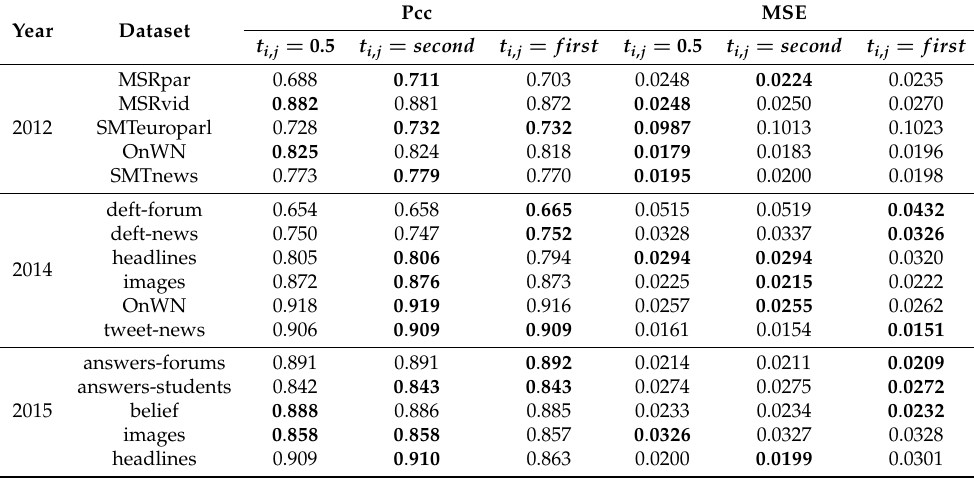
Table 6. Influence of parameters t i , j on sentence semantics of different corpora. The figures in bold- type refer to the maximum Pearson correlation coefficient of each corpus. The figures in red-type refer to the minimum mean squared error of each corpus.